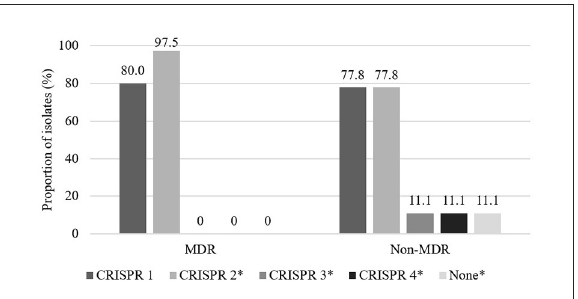
FIGURE1 Distribution of CRISPR between multidrug resistant (MDR) and non-multidrug resistant (non-MDR) isolates in 49 third- or fourth-generation cephalosporin-resistant avian pathogenic E. coli . Multidrug resistance was defined as resistance to three or more antimicrobial classes. The asterisk indicates that prevalence between MDR and non-MDR isolates in each CRISPR array is significantly different ( p < 0.05).